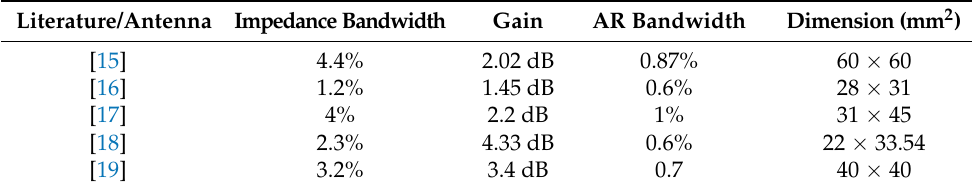
Table 2. Comparison of existing conventional fractal-DGS antenna.